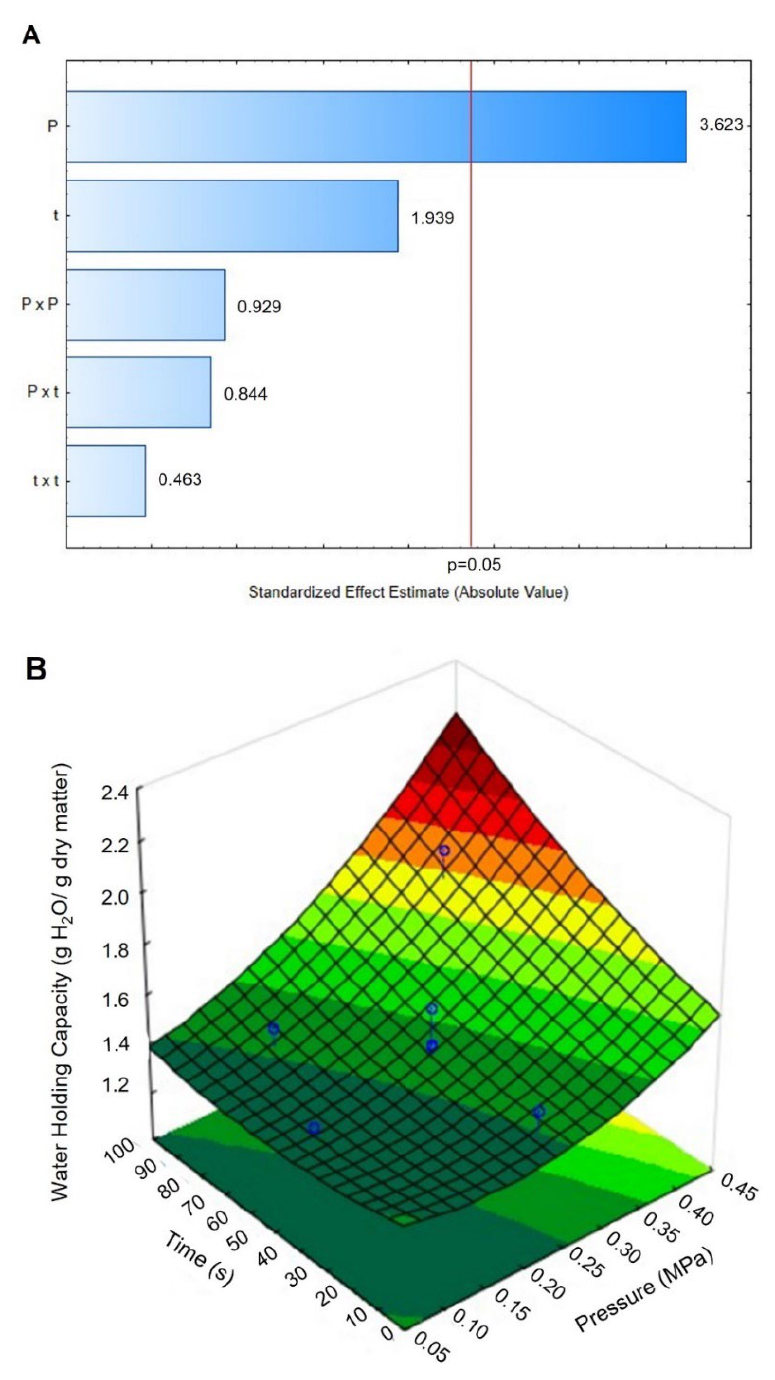
Figure 9. Effects of Pressure (MPa) and time (s) of DIC treatment on the water holding capacity (WHC) of maize kernels. ( A ) Pareto Chart and ( B ) surface response and fitting model. WHC = 1.146 − 1.114P + 3.306P 2 − 0.0034t + 0.000023t 2 + 0.0147P × t.